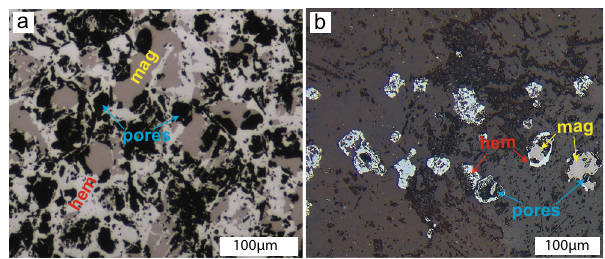
Fig. 5 Textures of ores from the Olympic Dam IOCG province. a Massive iron oxide ores from Torrens Dam (drill core TD 2), with hematite partially replacing magnetite. Hematite is porous with large pores. Pores are usually developed at the hematite – magnetite boundary. b Hematitised rock from Emmie Bluff (drill core SAE 7), with hematite partially replacing magnetite at grain rims and coarse porosity/gap developed along magnetite – hematite boundaries. Hematite grains are porous and usually display a large pore at their core, with only a few preserving some magnetite relicts at